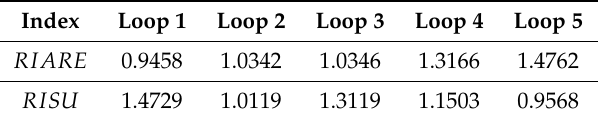
Table 6. Indexes for RIARE and RISU in the reference tracking experiment (MPC is the C 2 and FOMPC the C 1 according to Equations (25) and (26)).